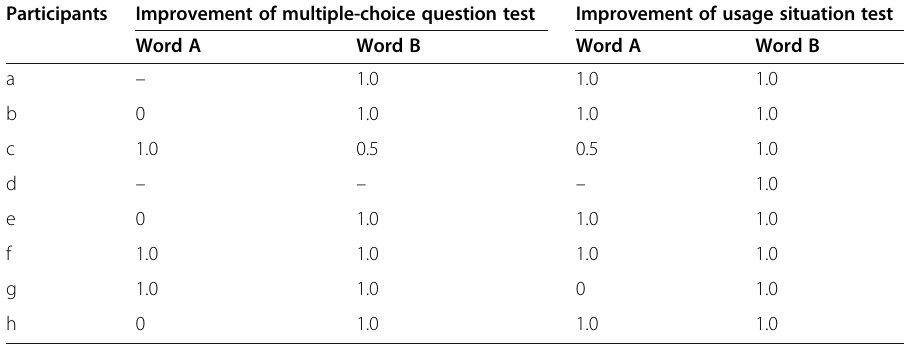
Table 5 Improvement rates of the multiple-choice question test and usage description test